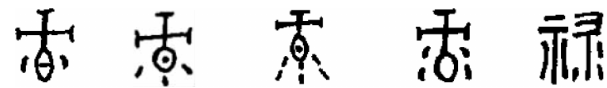
Figure 1. Oracle bone script and bronze script for the hieroglyphs (Zou,